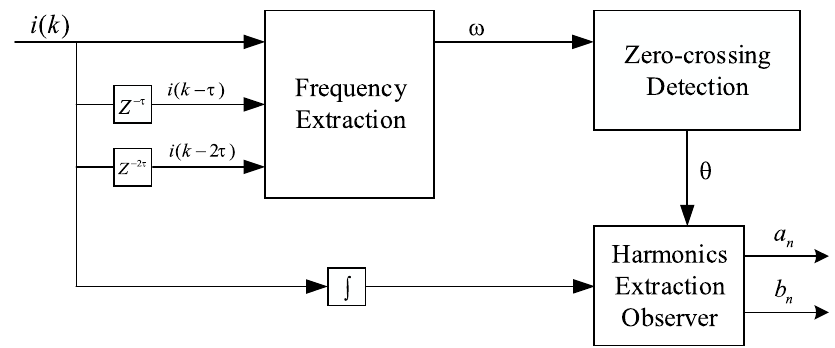
Figure 1. Block diagram of harmonics